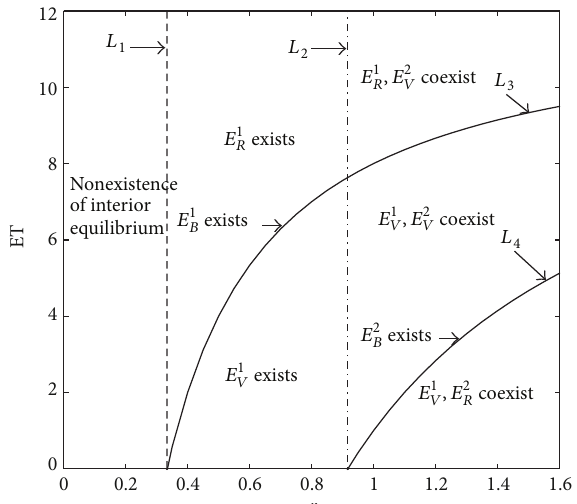
Figure 2: Regular/virtual equilibrium. The parameter values are fixed as follows: 𝑎 = 0.7 , 𝑏 = 0.6 , 𝑘 = 12 , 𝛽 = 0.5 , 𝛿 = 0.25 , 𝑞 1 = 0.25 , and 𝑞 2 = 0.1